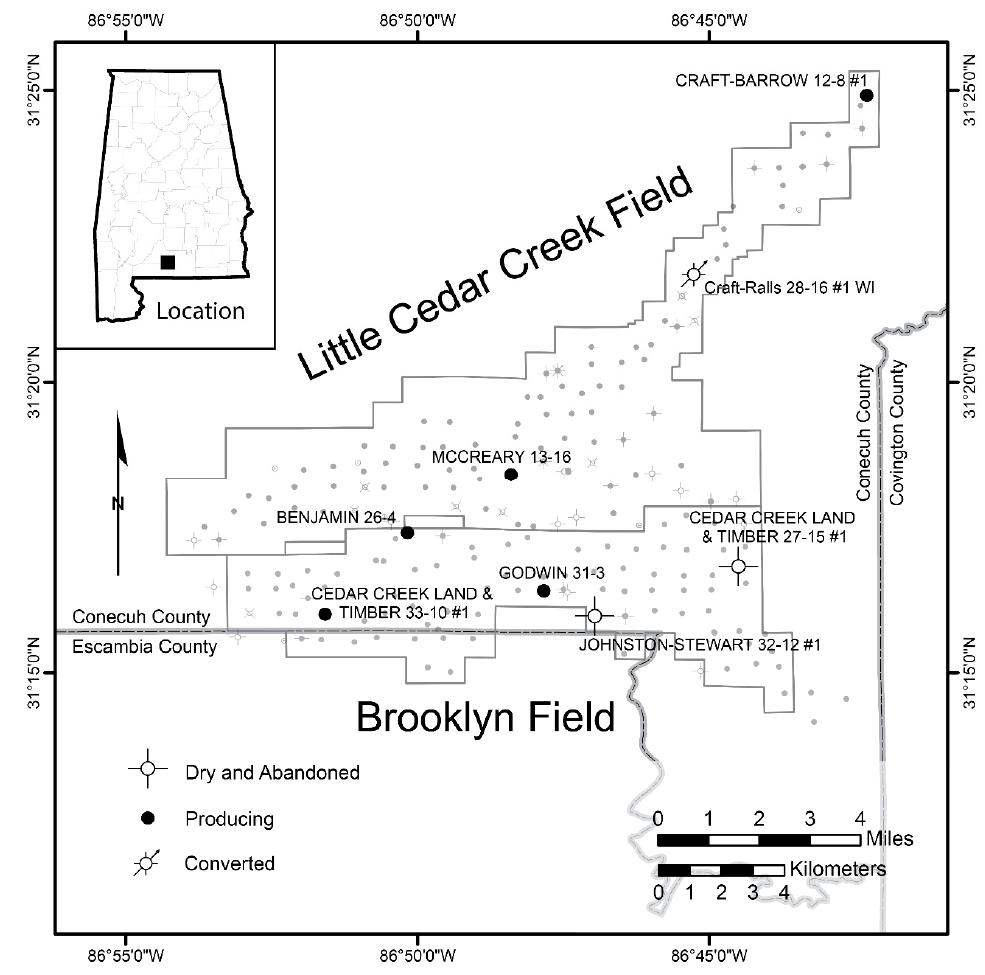
Figure 3. Wells used from the Little Cedar Creek (northern) and Brooklyn (southern) fields for this study in southern Alabama, United States. All wells in both fields are shown as of November 2018. Datum of geographic coordinate is NAD83.